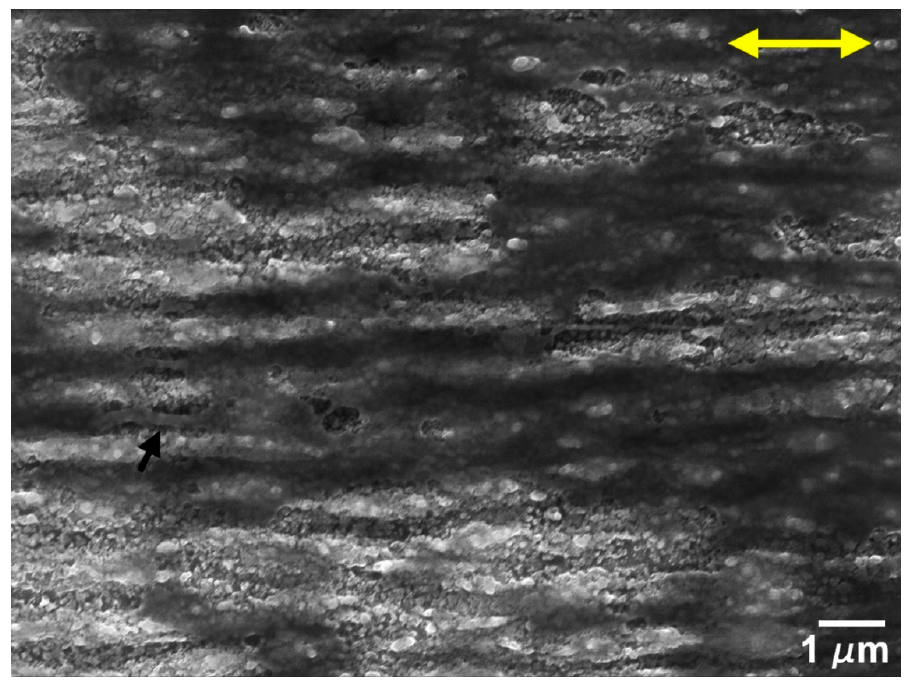
Figure 11. SEM micrograph of a wear track produced at 10 mN and 400 cycles. The double arrow indicates the sliding direction.